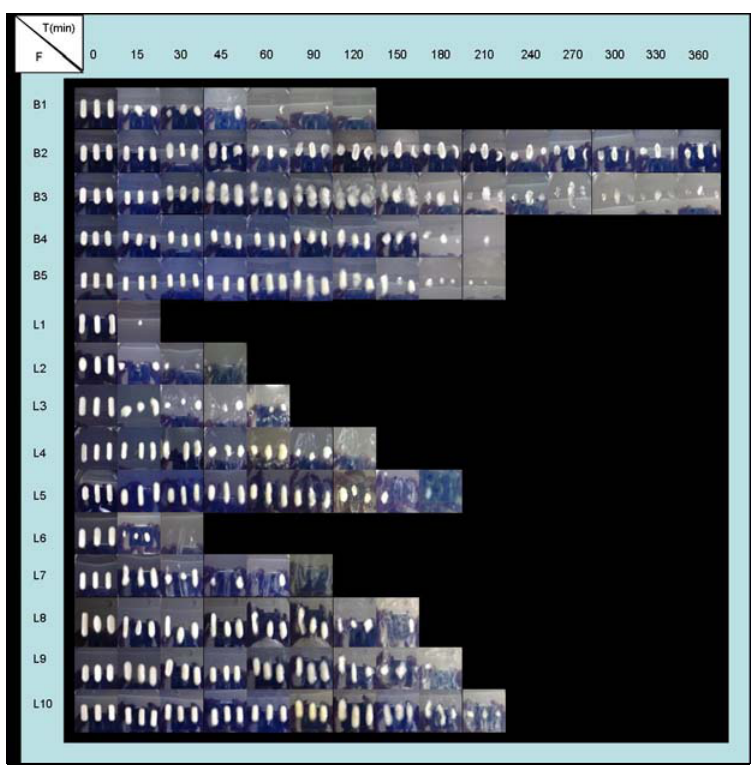
Figure 4. Appearance evolution of freeze-dried formulations (F) during swelling tests in demineralized water.